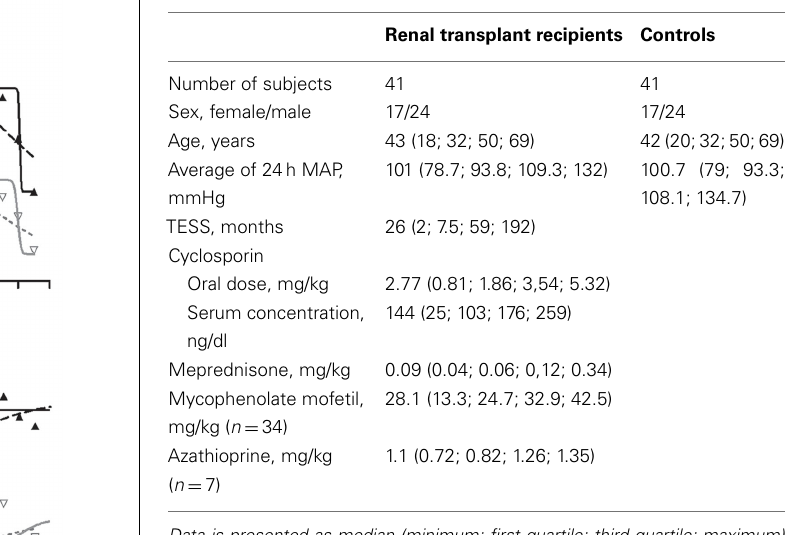
Table 1 | Characteristics of renal transplant recipients and